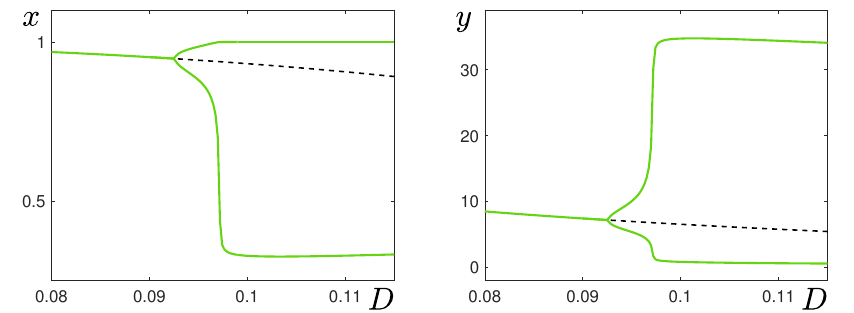
Figure 1. Bifurcation diagram of system (1): extreme values of x - and y -coordinates of the correspond- ing stable equilibria and cycles (green, solid) and unstable equilibria (black, dashed). Here, one specific feature should be underlined. As the parameter D in the zone D > D ∗ increases, the amplitude of self-oscillations, both x and y , grows. However, the growth rate is highly nonuniform: there exists a D -zone where the amplitude sharply jumps. This narrow D -zone is classified as the zone of the Canard explosion